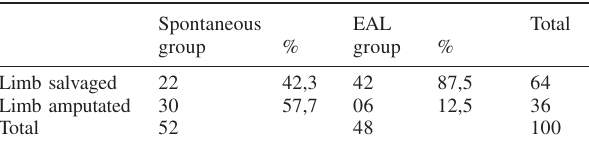
Table 5 – Limb salvage following revascularization surgery